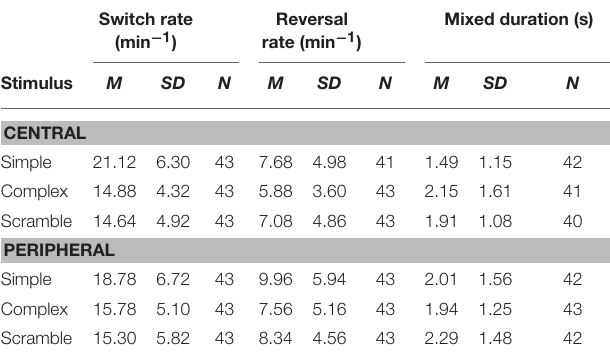
TABLE 1 | Descriptive statistics for switching rates, reversal rates, and median mixed